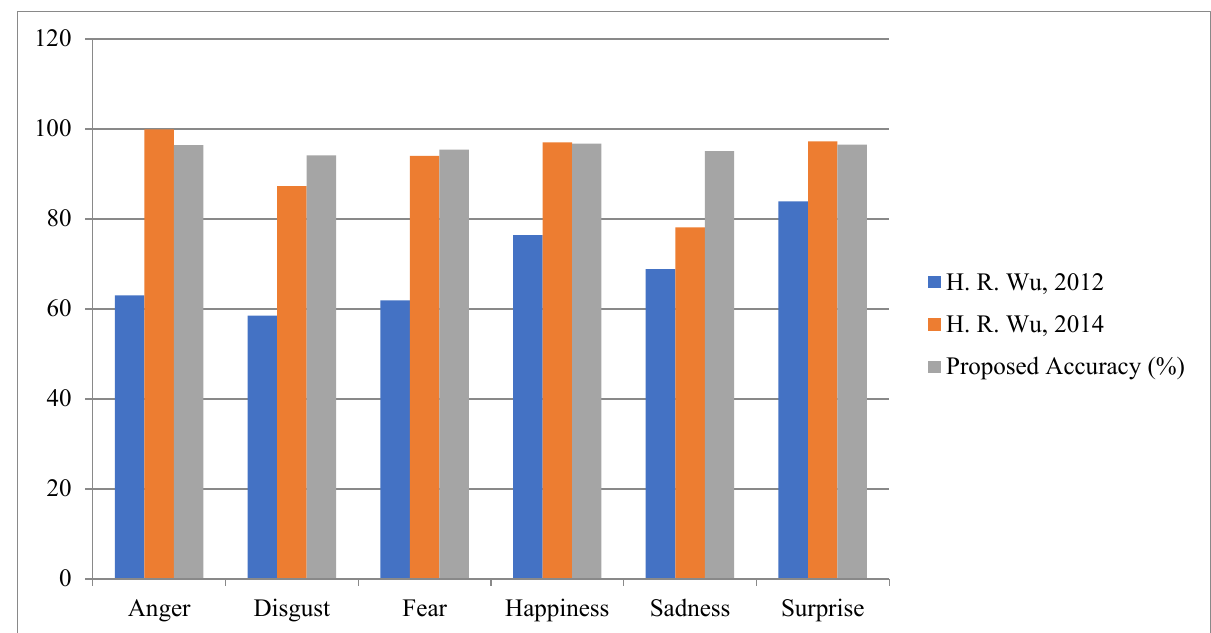
Figure 18. Accuracy Comparison for Facial Expression JAFFE.